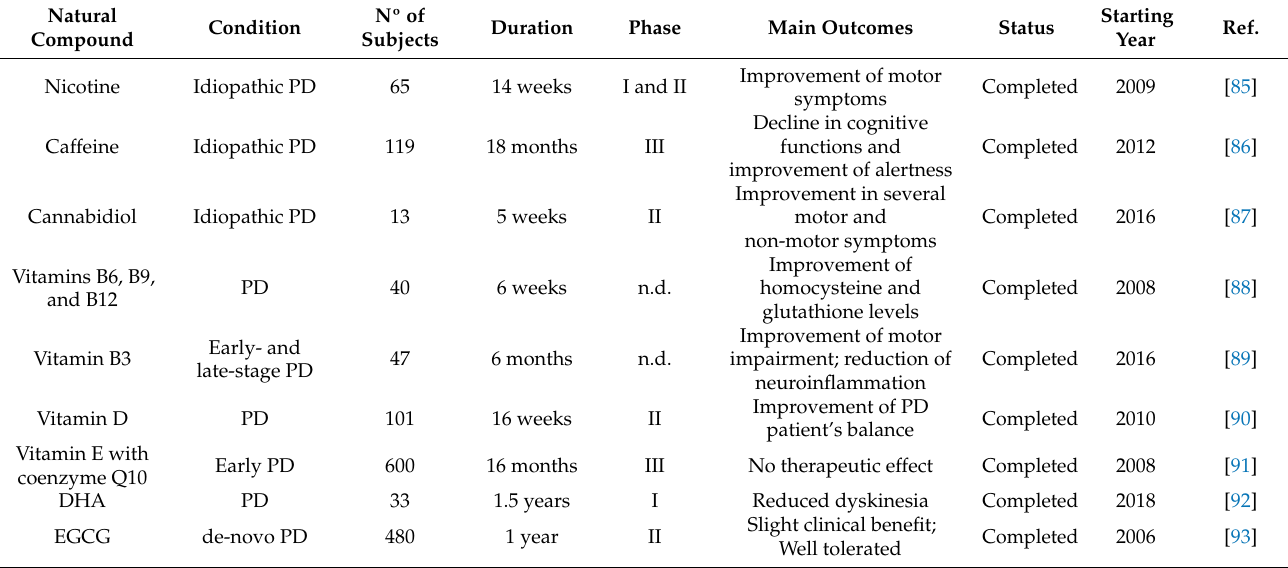
Table 2. Natural compounds in clinical trials for PD